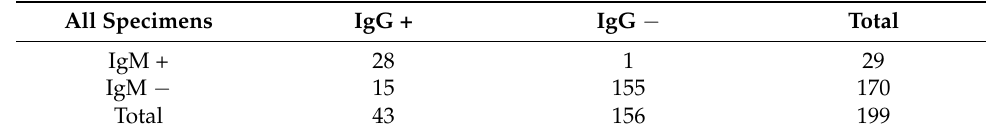
Table 1. Numbers of anti-SEOV IgM and IgG antibody-positive wild rats.